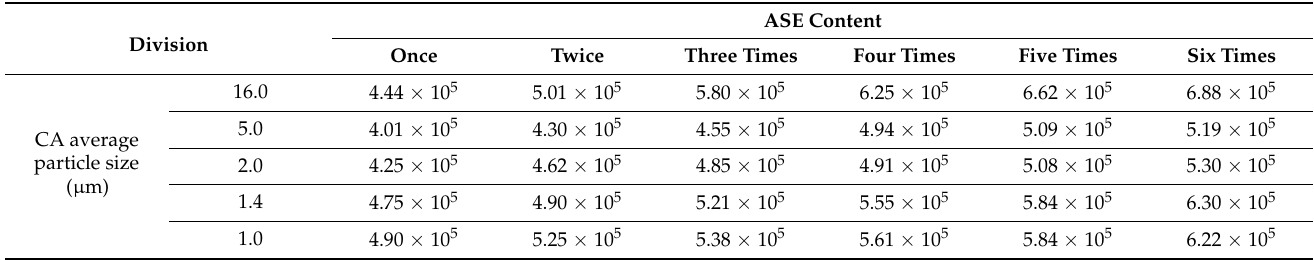
Table 6. Viscosity measurement results (mPa·s).